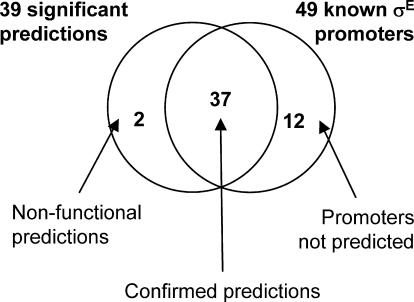
Venn Diagram of Predicted and Known σE Promoters in E. coli K-1239 predictions from the promoter library were identified as highly significant, of which 37 were confirmed. A total of 49 known σE promoters were confirmed from the literature and additional experiments, of which 37 were successfully identified by the promoter prediction model (see text; Table 2).